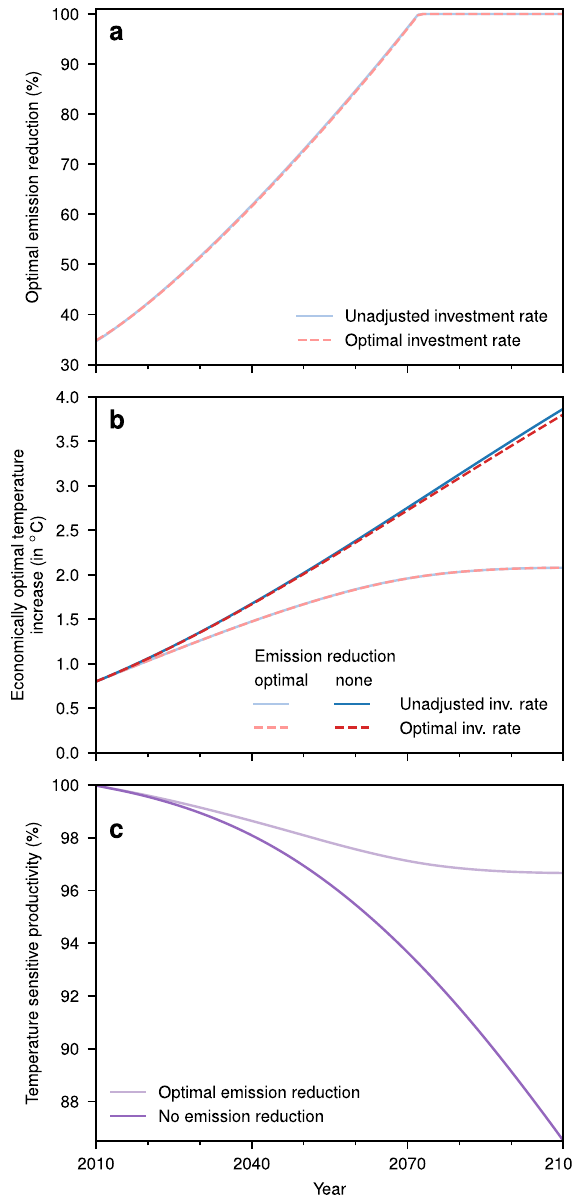
Fig. 7 Optimal mitigation and its effects. a Optimal emission reduction rates are almost identical for the two assumptions of investment behaviour. b Economically optimal mitigation limits warming to almost 2 °C by